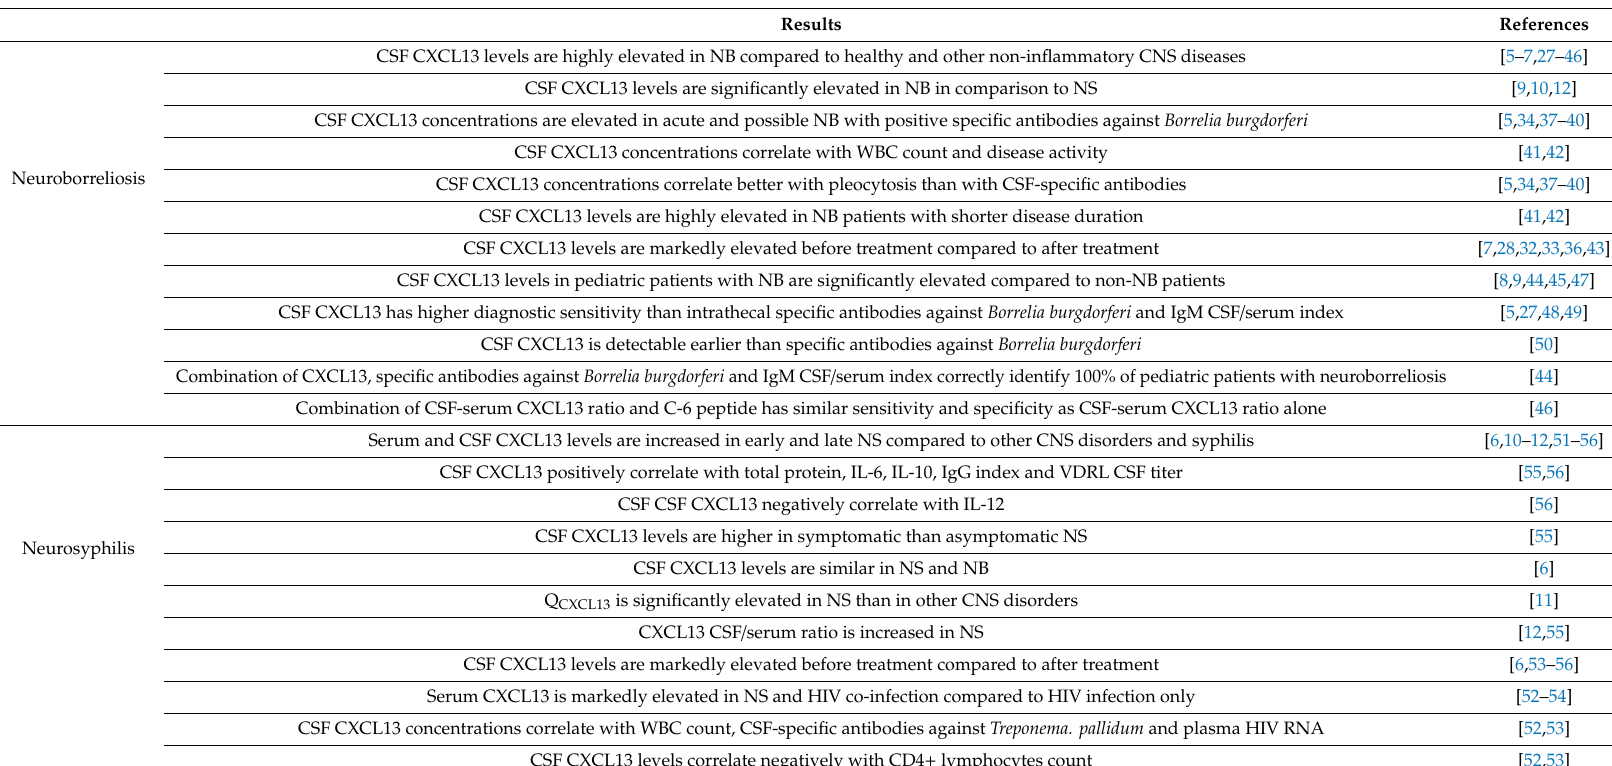
Table 1. Significance of Chemokine ligand 13 (CXCL13) as a candidate diagnostic marker for neuroborreliosis (NB) and neurosyphilis